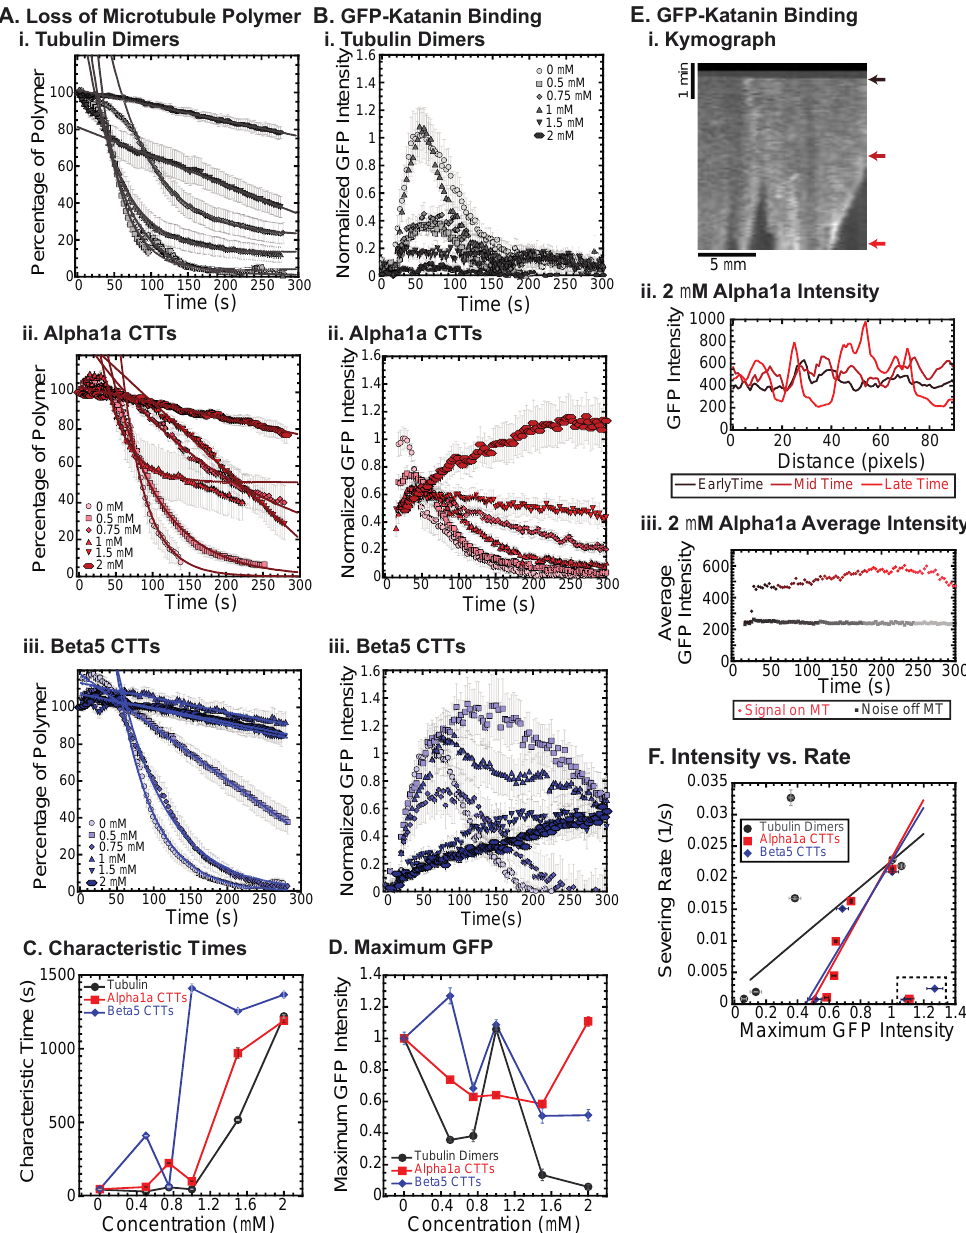
Figure 2 . Inhibition of katanin binding and severing by tubulin dimers, alpha CTTs, and beta CTTs. ( A ) Loss of polymer caused by increasing concentration of ( i ) tubulin dimers (gray), ( ii ) alpha CTTs (red), and ( iii ) beta CTTs (blue). The transition from exponential decay to linear decay is observed for loss of polymer data as it goes from no inhibitor (0 μM, lightest shade circles), low inhib itor (0.5 μM, light shade squares; 0.75 μM, light shade diamonds), medium inhibitor (1 μM, medium shade triangles with point up), to highest inhibitor (1.5 μM, darker shade triangles with point down, 2 μM, darkest shade hexagons). Each dataset is fit with a best fit equation to an exponential or linear decay with best fit parameters provided in the Supplemental Information Table S2. ( B ) The data for the GFP-katanin binding by increasing concentration of ( i ) tubulin dimers (gray), ( ii ) alpha CTTs (red), and ( iii ) beta CTTs (blue). The data were normalized by the maximum when there was no inhibitor (0 μM, lightest shade circles). Data for low inhibitor (0.5 μM, light shade squares; 0.75 μM, light shade diamonds), medium inhibitor (1 μM, medium shade triangles with point up), to highest in- hibitor (1.5 μM, darker shade triangles with point down, 2 μM, darkest shade hexagons) are shown. ( C ) The characteristic decay times for loss of polymer as a function of concentration for tubulin (gray circles), alpha1 CTTs (red squares), and beta CTTs (blue diamonds). Error bars represent the uncer- tainty in the fit parameters. ( D ) The average normalized maximum for GFP-katanin binding to